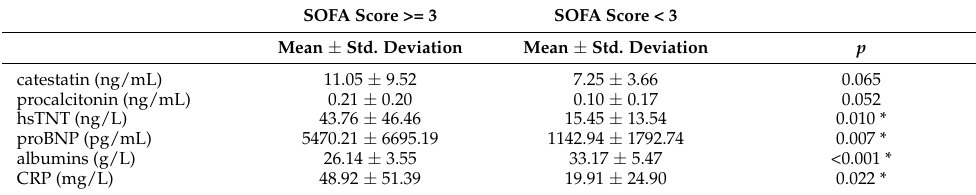
Table 3. Differences between groups of participants with SOFA < 3 ( n = 18) and SOFA >= 3 ( n = 14) in CST and cardiovascular and inflammatory parameters (Student’s t -test, one-tailed). SOFA Score >= 3 SOFA Score < 3 Mean ± Std. Deviation Mean ± Std. Deviation p catestatin (ng/mL)